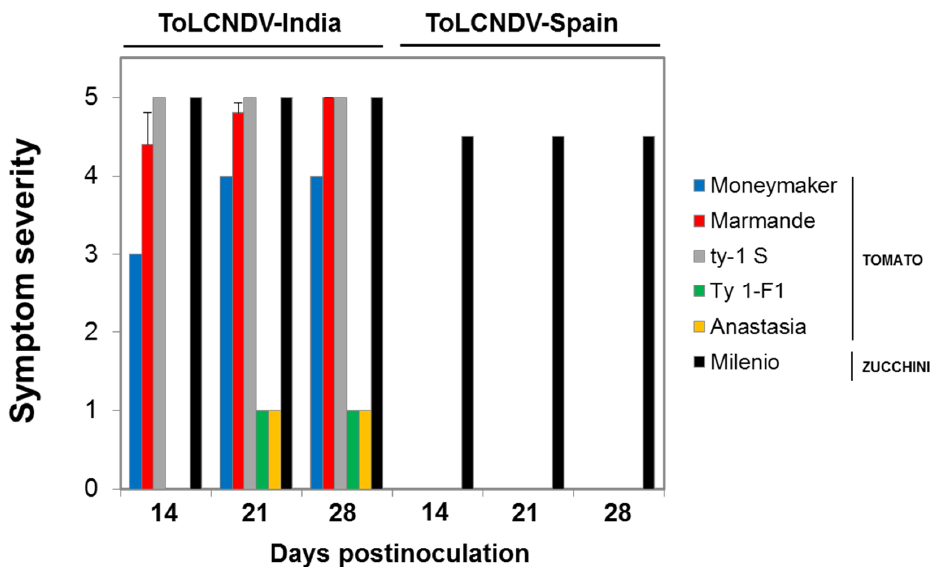
Figure 5. Severity of ToLCNDV infection in tomato and zucchini squash plants. Evolution of symptom severity (0, no symptoms; 5, maximum symptom severity observed for the Indian isolate) in tomato and zucchini squash plants agroinoculated with tomato leaf curl New Delhi virus (ToLCNDV) isolates from Spain (ToLCNDV ‐ [ES ‐ Alm ‐ 661 ‐ Sq ‐ 13]) and India (ToLCNDV ‐ [IN ‐ ND ‐ Svr ‐ 92]) (Assay 1 in Table 4); values are the mean ± standard error for infected plants of 10 tomato and zucchini squash plants inoculated.